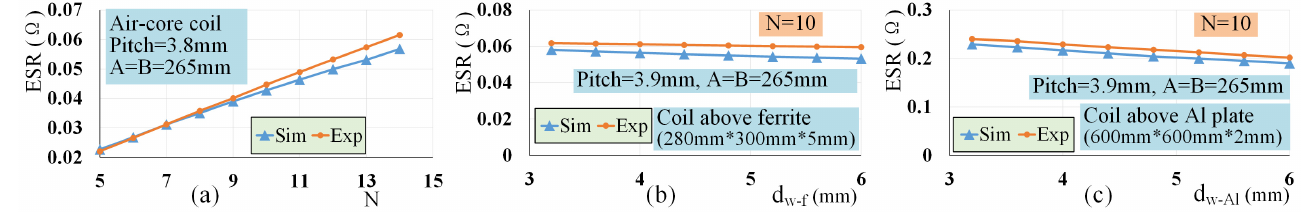
Figure 6. Comparisons between simulated and measured coil ESR. ( a ) ESR versus N . ( b ) ESR versus d w − f . ( c ) ESR versus d w − Al (distance between copper wire and aluminum plate).